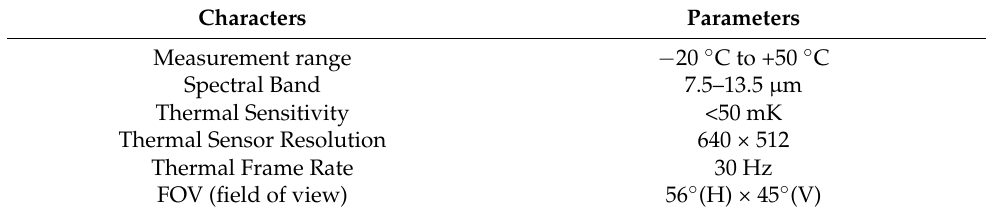
Table 2. The main characteristics of the FLIR Duo® Pro R thermal